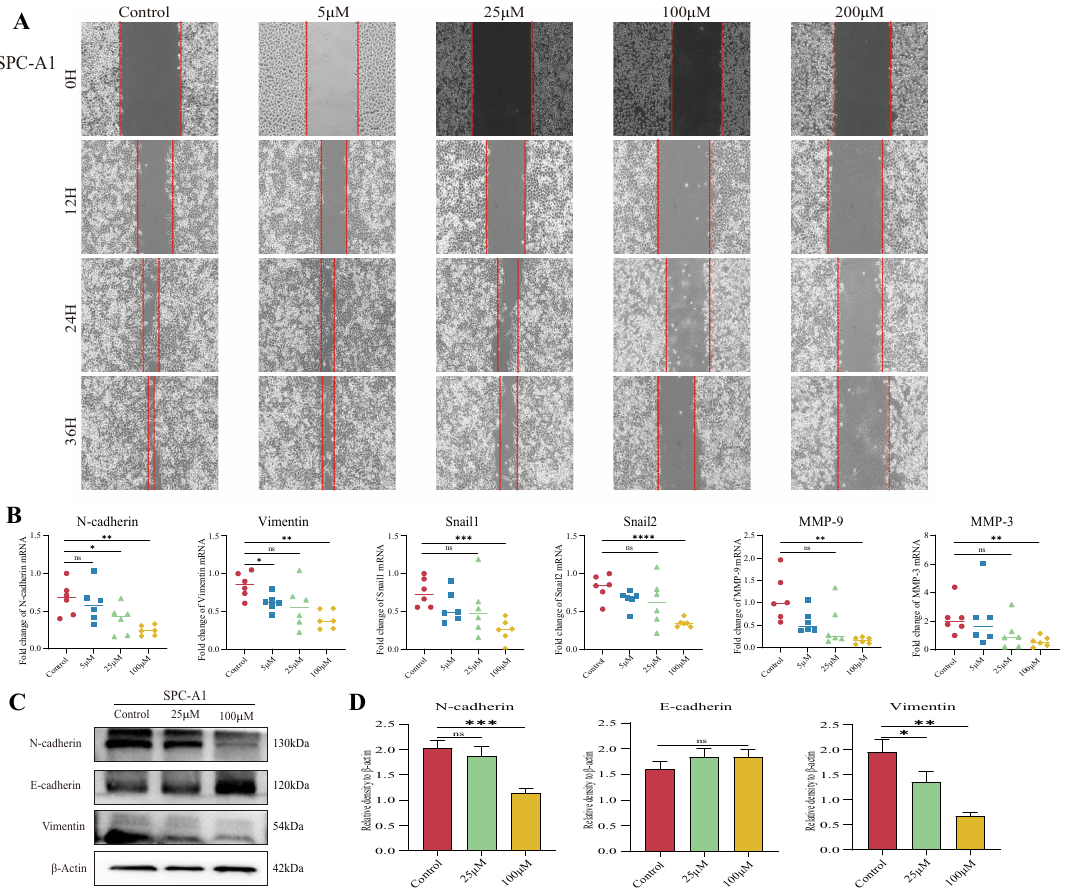
Figure 2. TAX inhibits migration of SPC-A1 cells. ( A ) Representative results of the wound-healing assay with SPC-A1 cells. ( B ) The expression of several key regulators of cell metastasis, adhesion, and migration in SPC-A1 cells was detected by RT-qPCR, after the treatment of TAX for 48 h. ( C , D ) The expression of several key EMT-related proteins was detected by western blotting after the treatment of TAX for 48 h. Images were quantified and statistically analyzed. ns, not significant, * p < 0.05, ** p < 0.01, *** p < 0.001, **** p < 0.0001. (Student’s t -test). Data are presented as mean ±